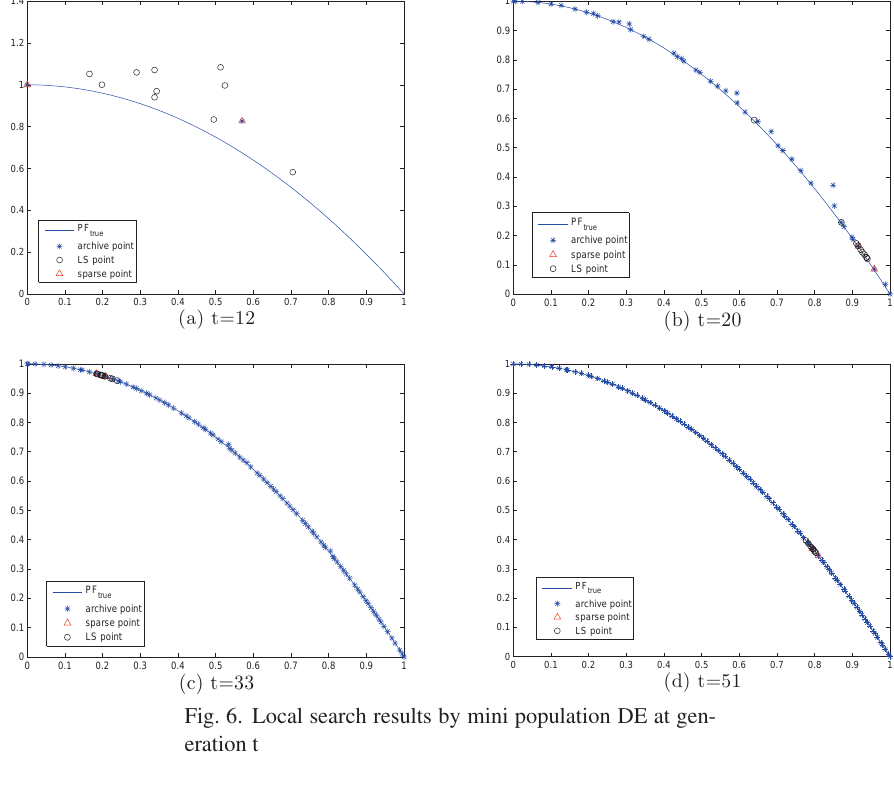
Fig. 6. Local search results by mini population DE at gen- eration